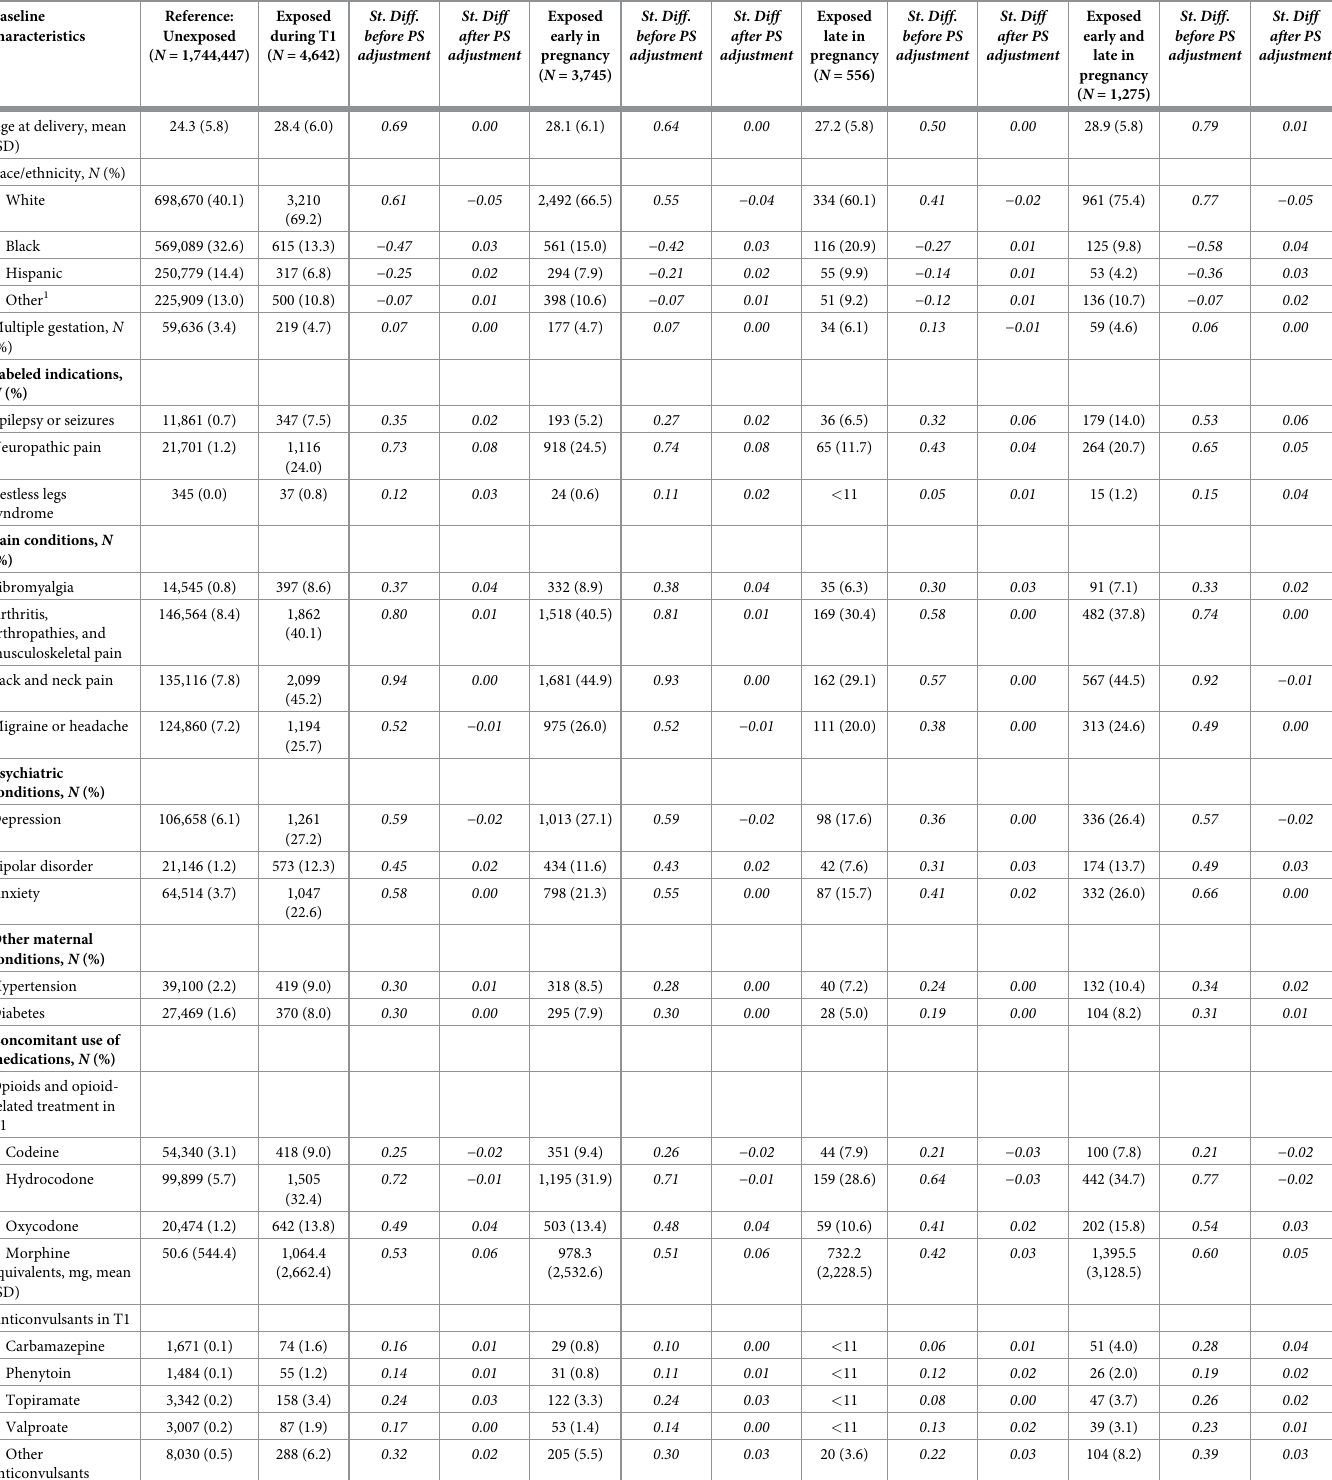
Table 1. Selected baseline characteristics of gabapentin-exposed and unexposed women before PS adjustment, with standardized differences before and after PS adjustment. Baseline